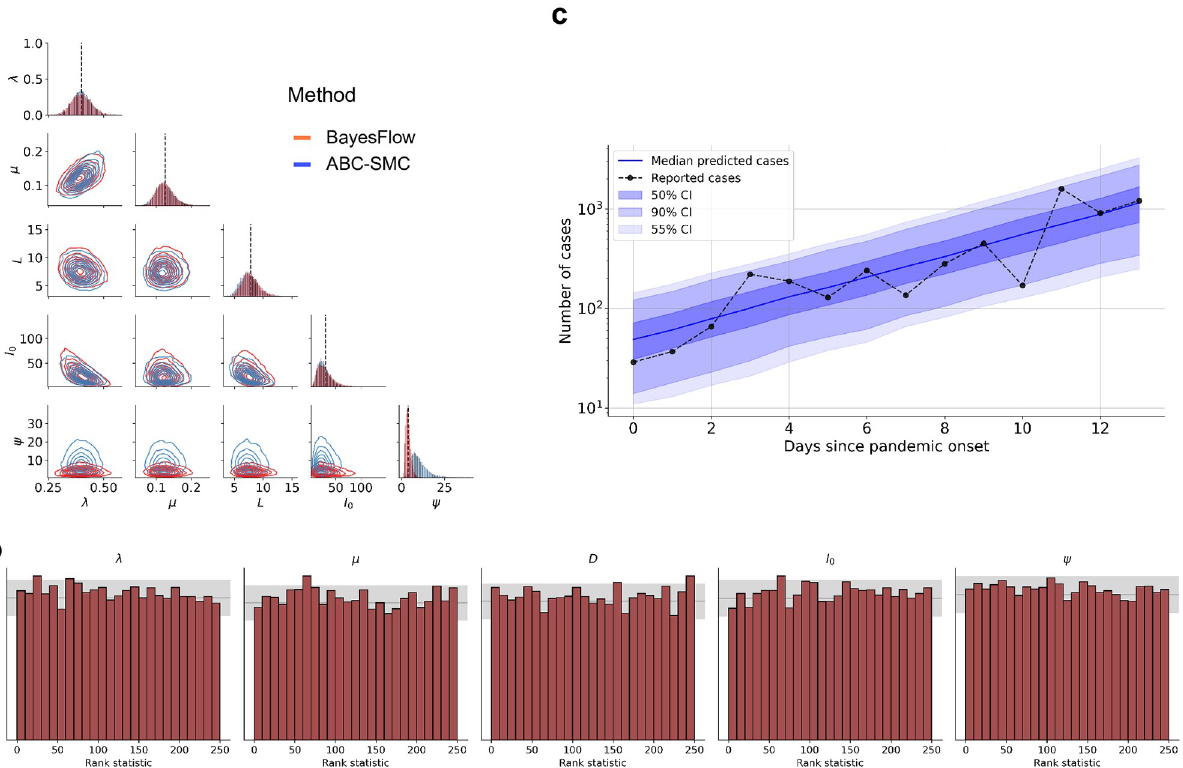
Fig 3. (a) Bivariate posteriors over the five model parameters obtained by OutbreakFlow (red) and ABC-SMC (blue) from cases reported during the first 14 days of the Covid-19 pandemic in Germany. Results of the two methods are very similar except for the dispersion parameter ψ , where OutbreakFlow achieves superior uncertainty reduction (see text for a brief discussion); (b) Model-based predictions based on the posteriors obtained by OutbreakFlow; (c) Simulation-based calibration (SBC) computed from 10000 simulated pandemic scenarios. The uniformity of the rank statistics indicates that there are no systematic biases in the approximate posteriors and implies trustworthy